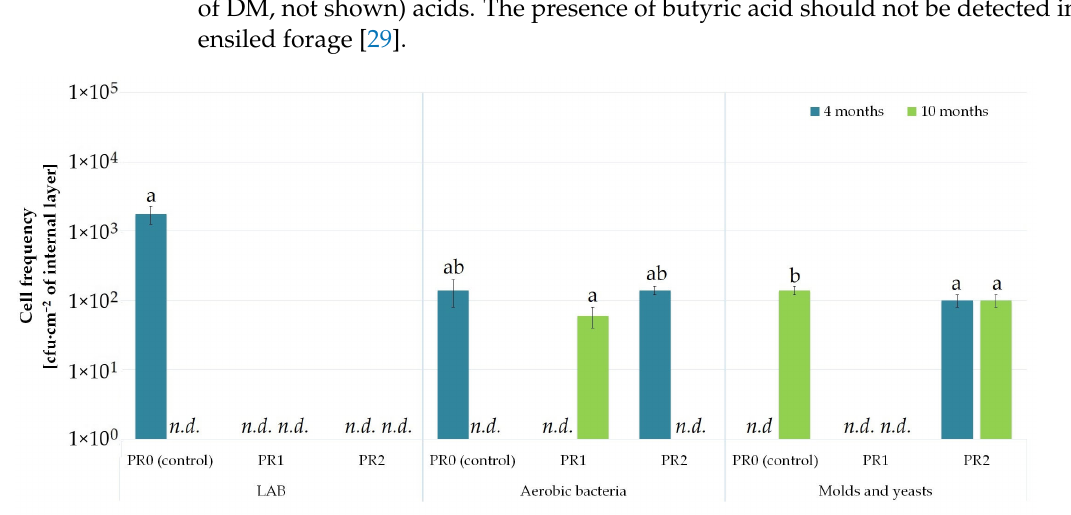
Figure 8. Microbial colonization of inner film surfaces during the second experimental stage. Storage time: 4 and 10 months. Bars marked with the same letters indicate no statistical difference ( p < 0.05); results were analyzed separately for each group of microorganisms; n.d.— not detectable.